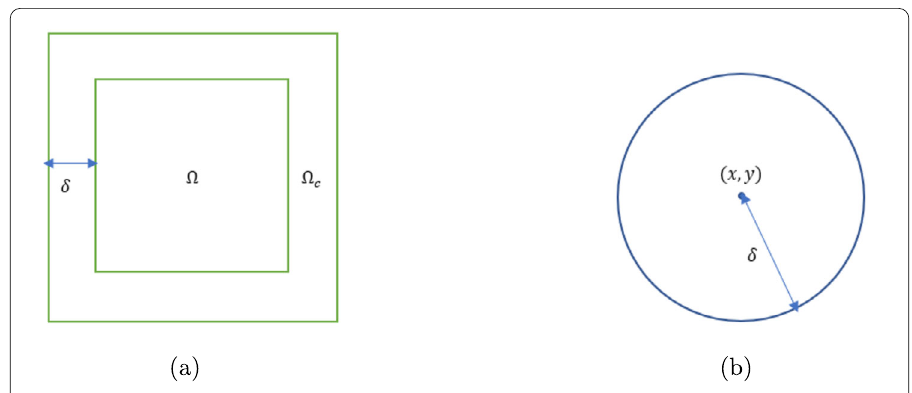
Figure 1 The left figure ( a ) shows the relationship between the domain Ω and the boundary zone Ω c with width δ ; The right figure ( b ) represents the integral domain B δ ( x ) in (1), which is an open disk centered at x with a radius